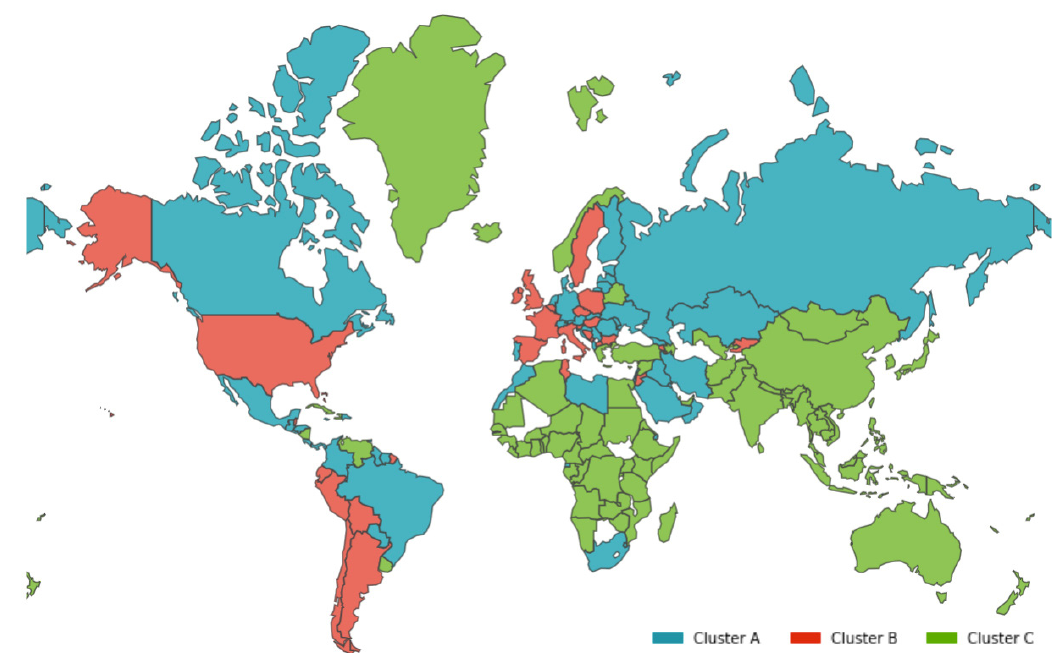
Figure 9. Geographic distribution of clusters of deaths per 100,000 of the population.